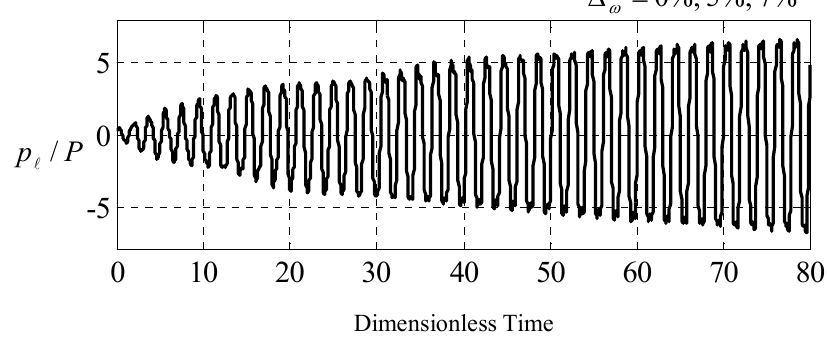
Figure 11. Temporal responses under temperature uncertainties.